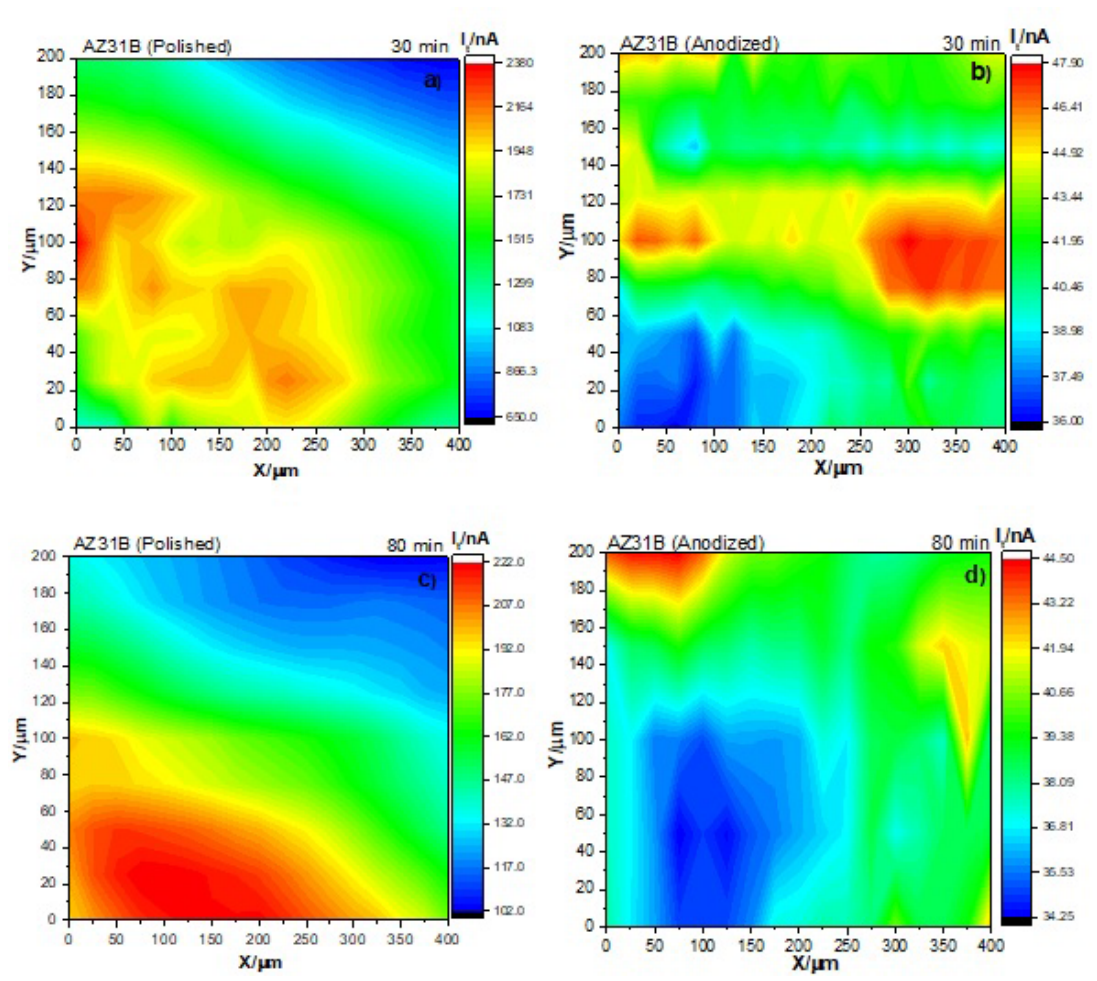
Figure 5. Hydrogen evolution (HE) maps of AZ31B alloy immersed in SBF. HE maps were acquired by SG/TC mode of SECM using a 25 µm Pt UME biased at 0.0 V versus Ag/AgCl. The SECM maps of AZ31B surface were acquired at the open circuit potential after 30 minutes of immersion for the as-polished (a) and anodized conditions (b), and after 80 minutes of immersion for the as-polished (c) and anodized conditions